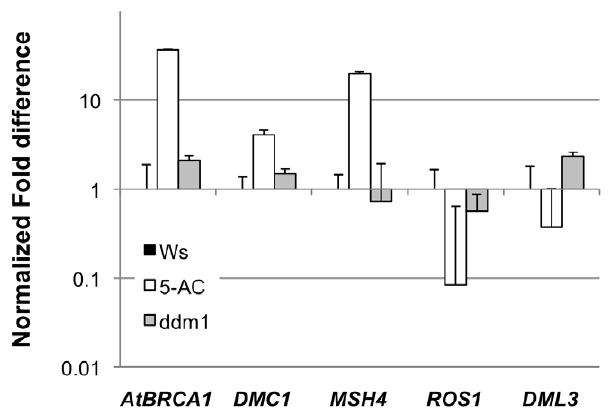
Figure 3. DNA damage repair genes are upregulated after 5-AC treatment. Quantitative RT-PCR expression ratios (5-AC and ddm1 normalized to Ws untreated control) for genes associated with repair of DNA damage or chromatin structure. Error bars indicate 95% confidence interval. AtBRCA1, ARABIDOPSIS THALIANA BREAST CANCER SUSCEPTIBILITY1 (At4g21070); DMC1, DISRUPTION OF MEIOTIC CON- TROL1 (At3g22880); ROS1, REPRESSOR OF SILENCING1 (At2g36490); MSH4, MUTS HOMOLOG4 (At4g17380).